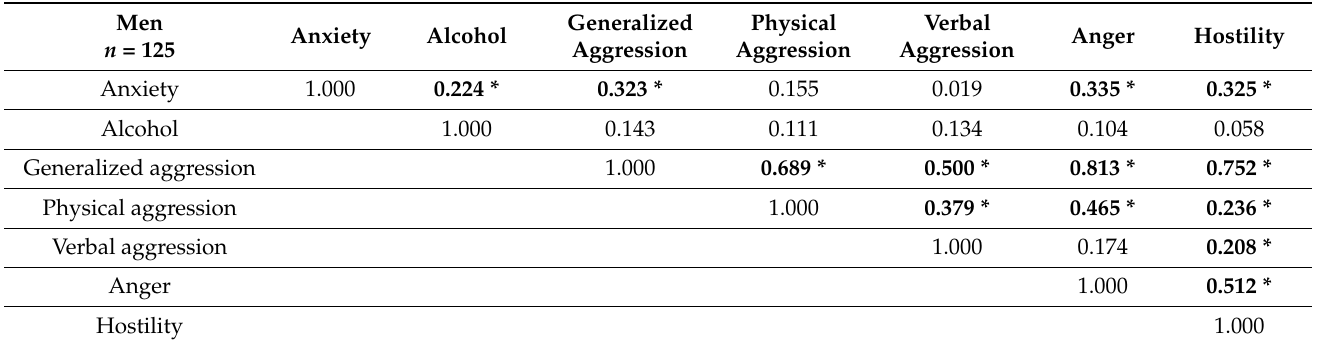
Table 5. Relationships between the severity of anxiety symptoms, the level of alcohol dependence and aggression in men.